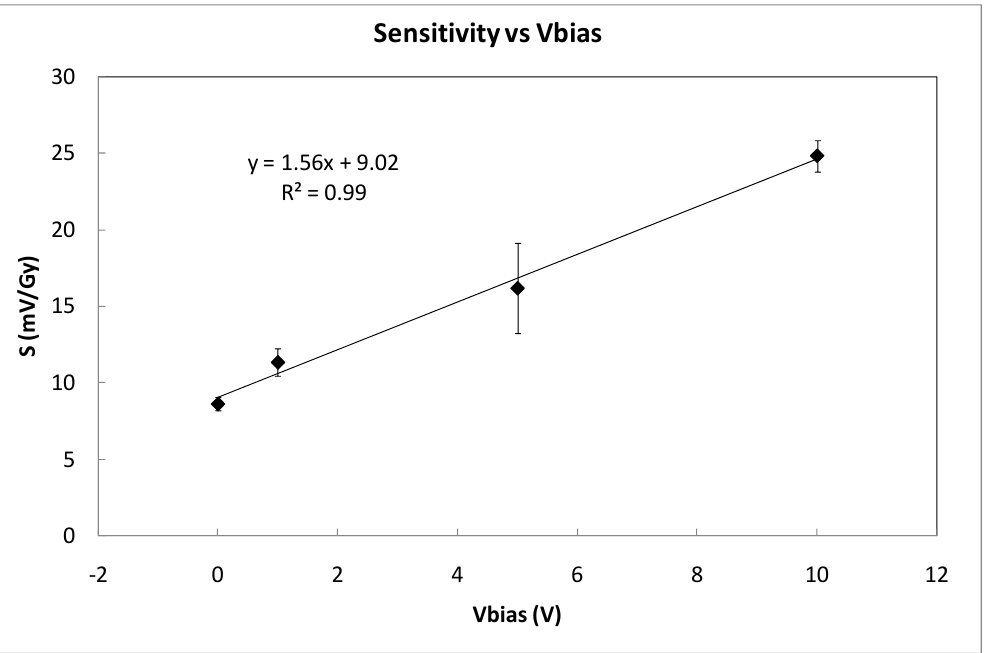
Figure 6. Average sensitivity as a function of the bias voltages (coverage factor k = 1). Symbols represent experimental data and the line indicates linear fitting.